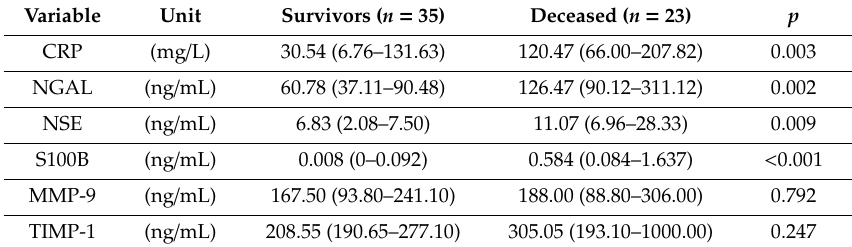
Table 2. Concentrations of studied biomarkers assessed in deceased patients and survivors 1 .